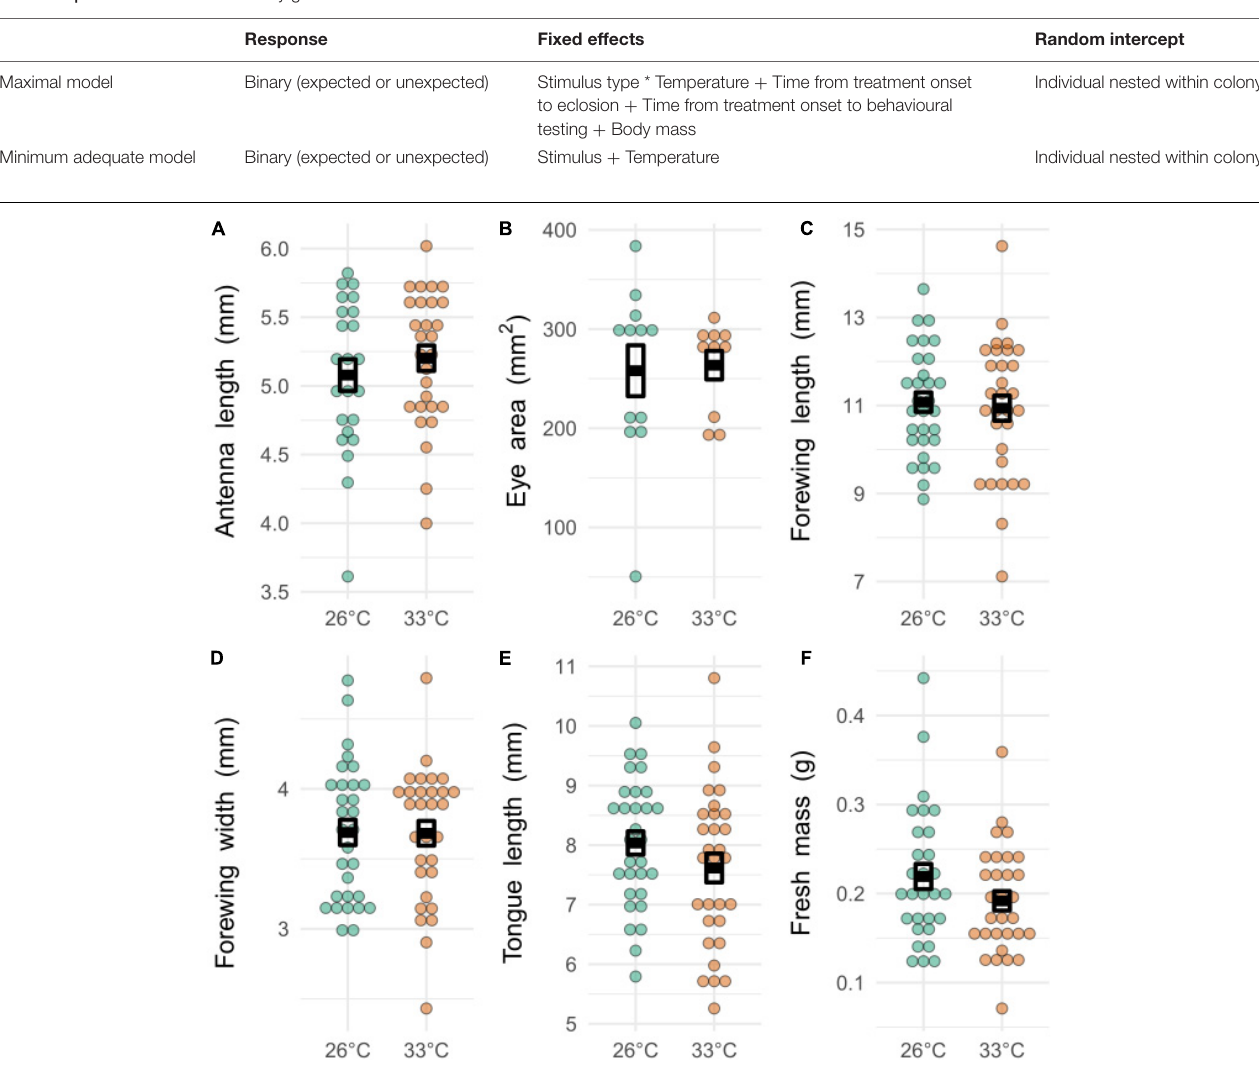
TABLE 4 | Structure of binomial family generalised linear mixed models.